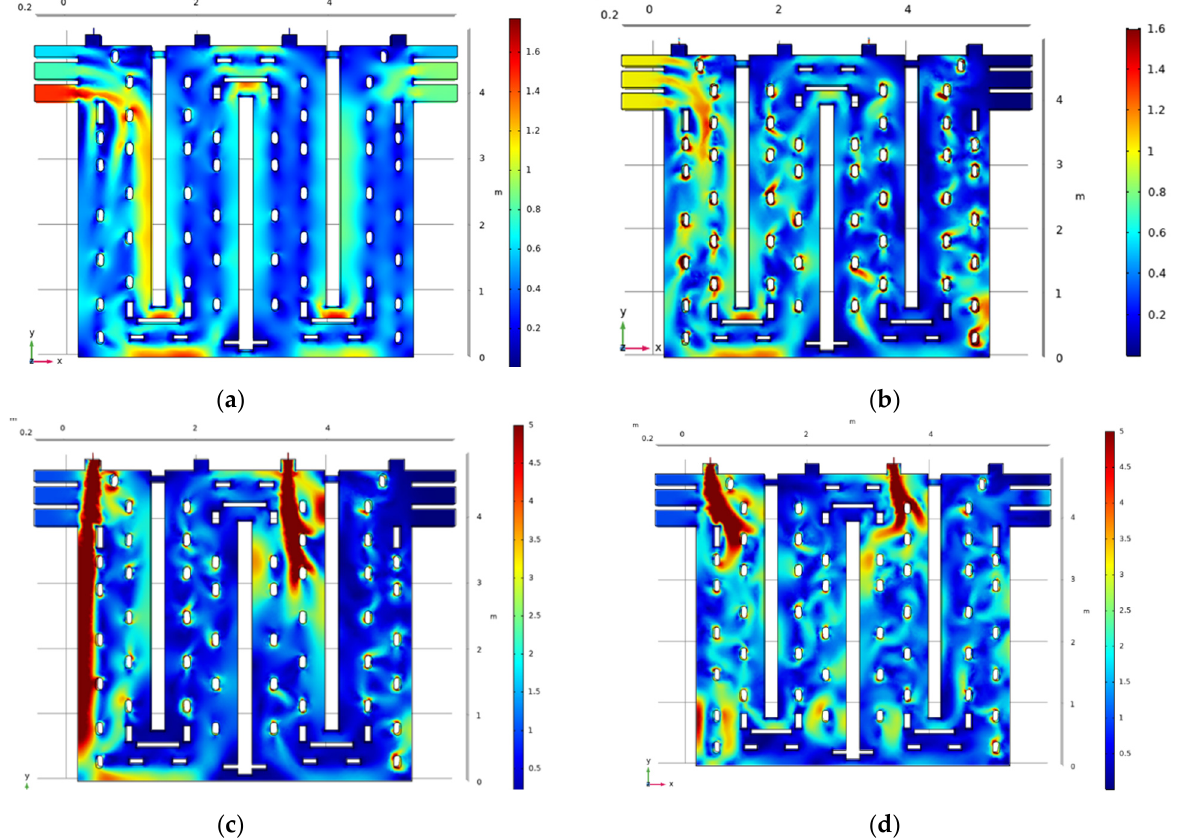
Figure 7. Velocity field plot of models 1 to 4 (dimensions m/s): ( a ) Model 1. Inlet velocity of fuel: 0. Viscosity 8.9 × 10 − 4 Pa·s. ( b ) Model 2. Inlet velocity of fuel: 0. Viscosity 1.8 × 10 − 5 Pa·s. ( c ) Model 3. Inlet velocity of fuel: 70 m/s. Viscosity 8.9 × 10 − 4 Pa·s. ( d ) Model 4. Inlet velocity of fuel: 70 m/s. Viscosity 1.8 × 10 − 5 Pa·s.